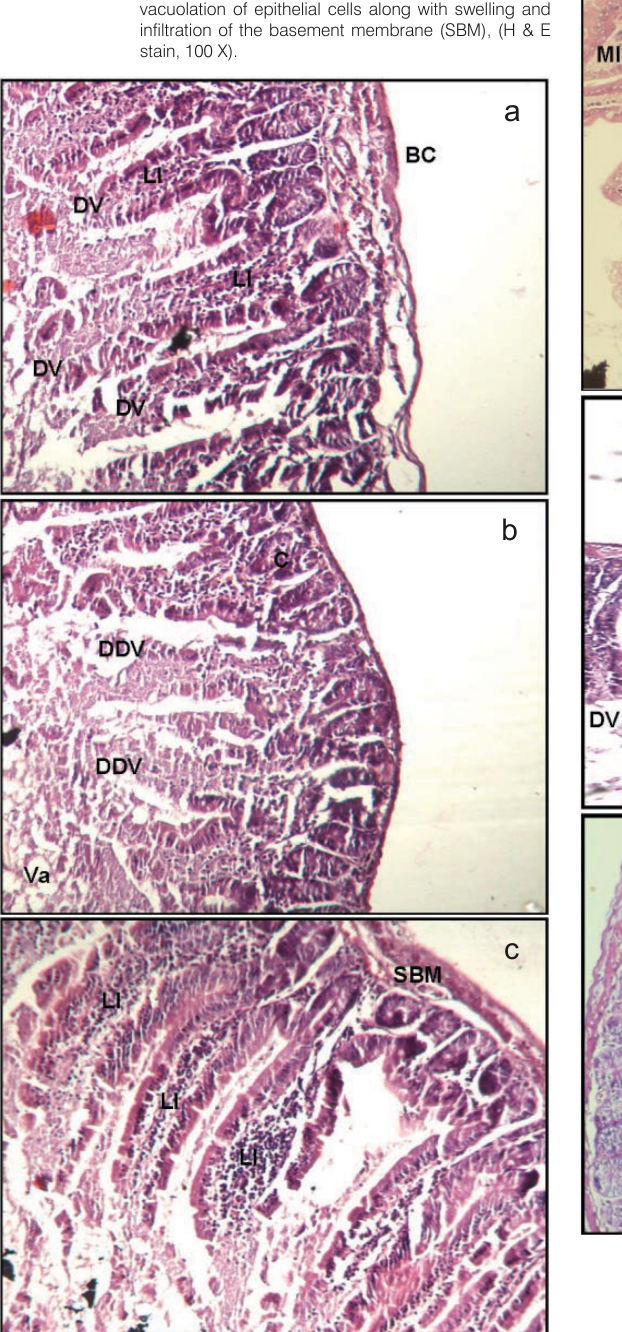
Figure 6. Photomicrograph of the small intestine of a Giardia - infected mouse (Group II); a) on day 7 PI showing hypertrophy and severely damaged microvilli (DV) tips along with heavy lymphocytic infiltration (LI); b) On day 14 PI showing severely damaged, inflamed intestinal mucosa with complete disruption of the microvilli (DDV), increased vacuolation (Va) of epithelial cells and oedema of lamina propria, a severe ileitis; c) on day 21 PI showing heavy lymphocytic infiltration (LI) in the microvilli (V) and lamina propria (LP). The villi are swollen with dissolved edges (DV) and increased vacuolation of epithelial cells along with swelling and infiltration of the basement membrane (SBM), (H & E stain, 100 X).